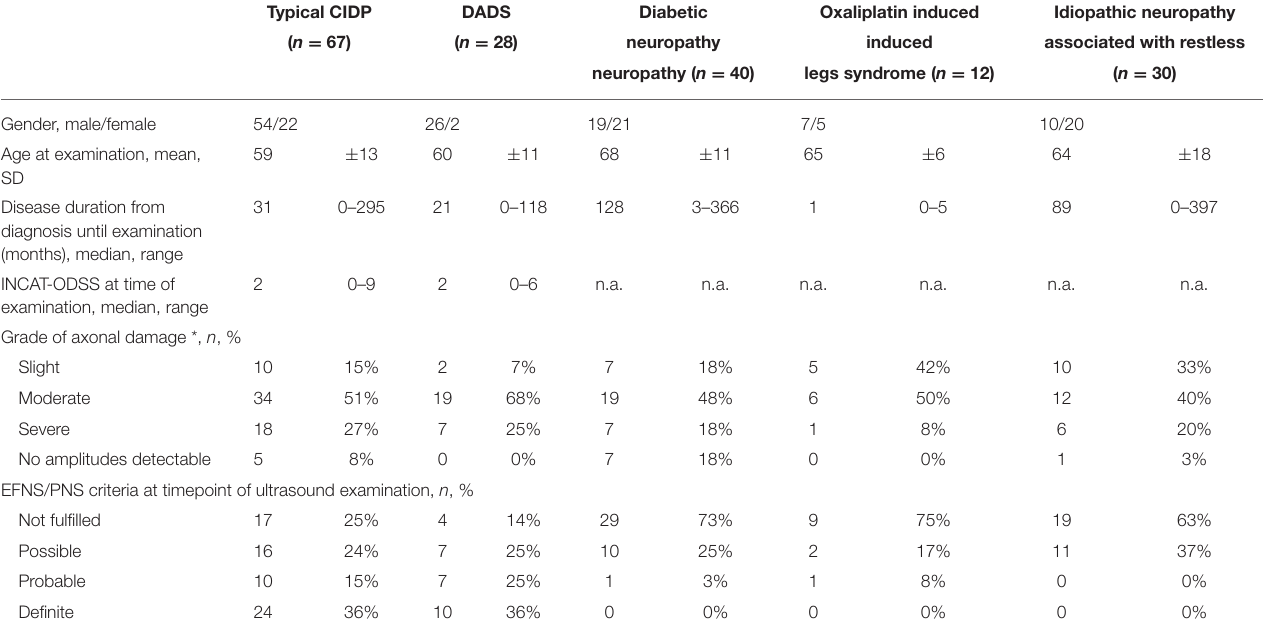
TABLE 2 | Demographics, disease characteristics, grade of axonal damage, and European Federation of Neurological Societies/Peripheral Nerve Society (EFNS/PNS) criteria of all subgroups. Typical CIDP DADS Diabetic Oxaliplatin induced Idiopathic neuropathy ( n = 28) neuropathy induced associated with restless neuropathy ( n = 40) legs syndrome ( n = 12)